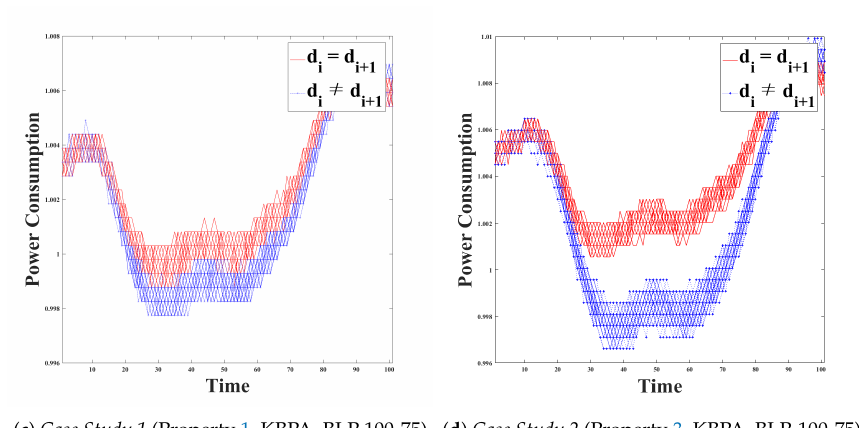
Figure 3. Classification result of Points of Interest (PoIs) (Hardware Implementation, Power Consumption).